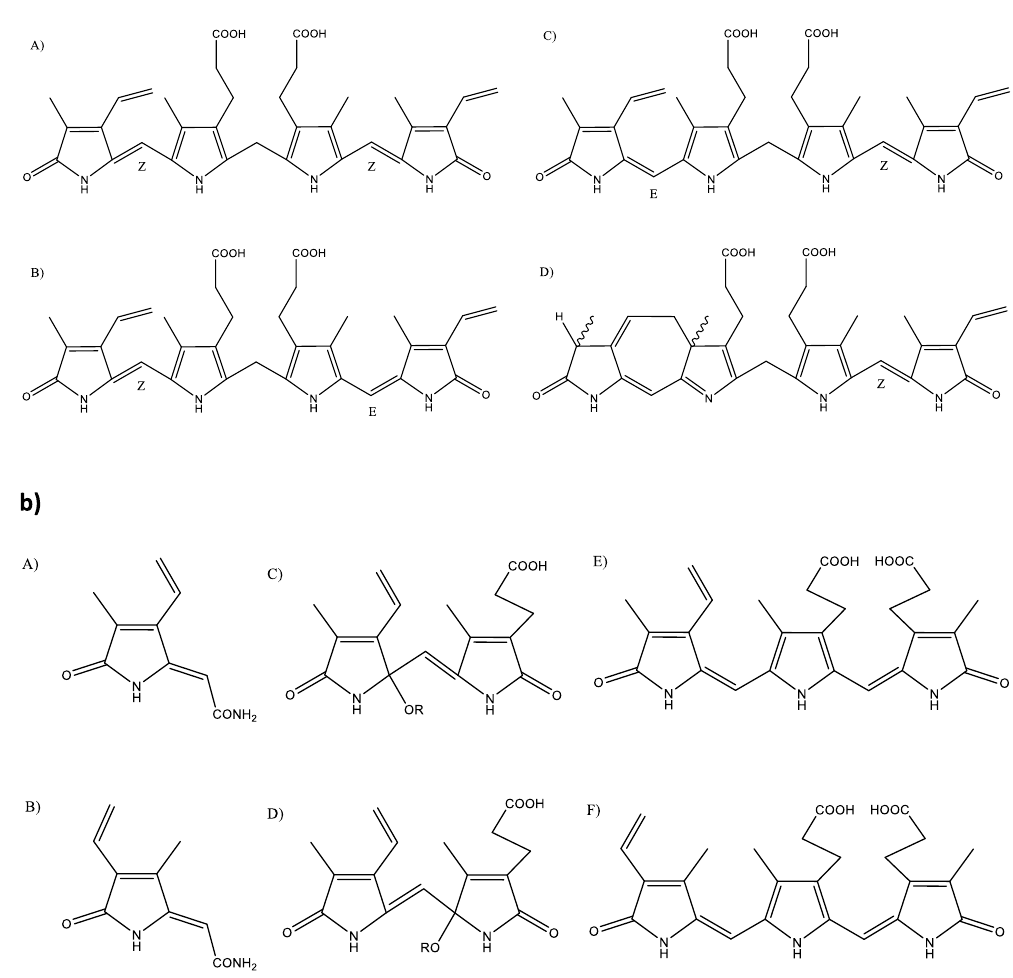
Figure 1. ( a ) Bilirubin and bilirubin PIs. (A) Z,Z -Bilirubin IX α ; (B) Z,E -Bilirubin IX α ; (C) E,Z -Bilirubin IX α ; (D) Z -Lumirubin Ix α . ( b ) Bilirubin oxidation products. Monopyrrolic: (A) BOX A, (B) BOX B; Dipyrrolic: (C,D) Propentdyopents; Tripyrrolic: (E) Biopyrrin a, (F) Biopyrrin b.